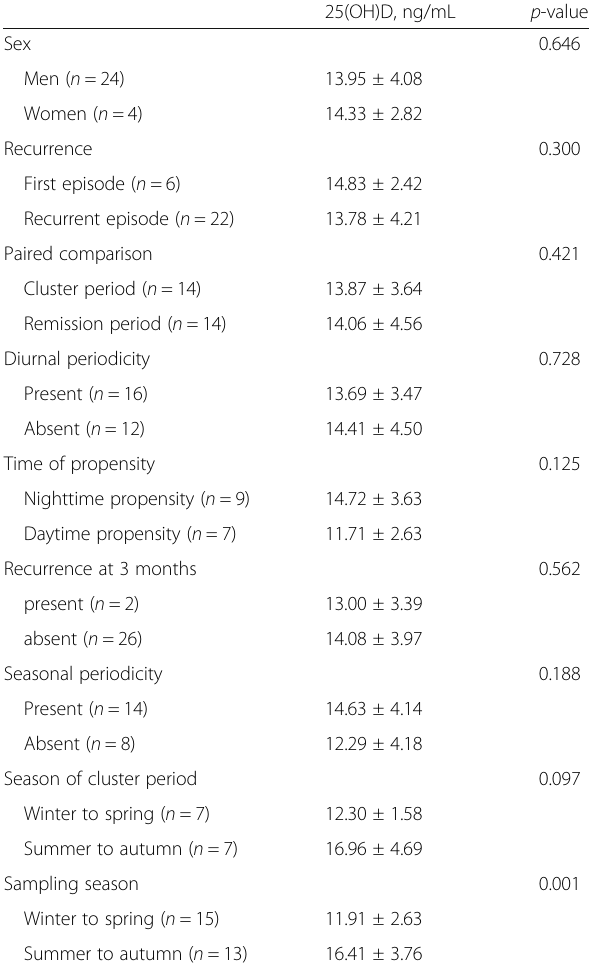
Table 2 Vitamin D levels according to clinical variables in the patients with cluster